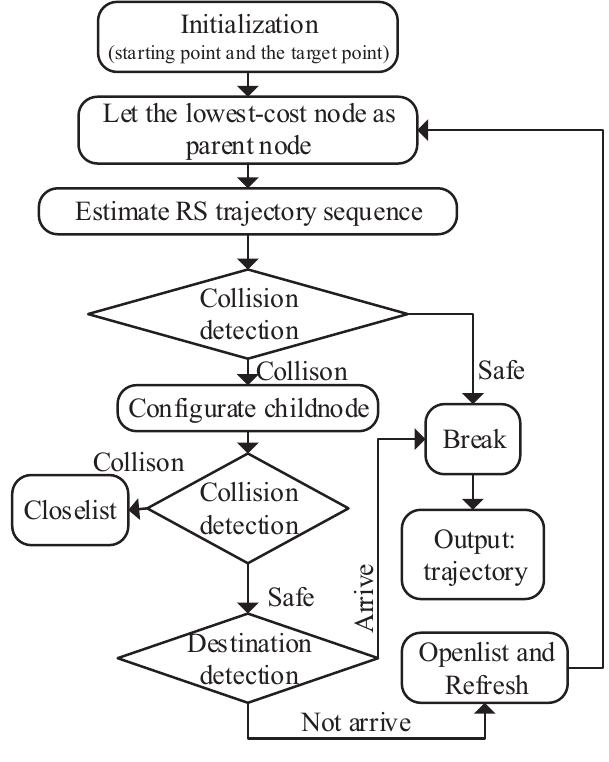
Figure 5 Flowchart of X-Y- u -T 4D A-star